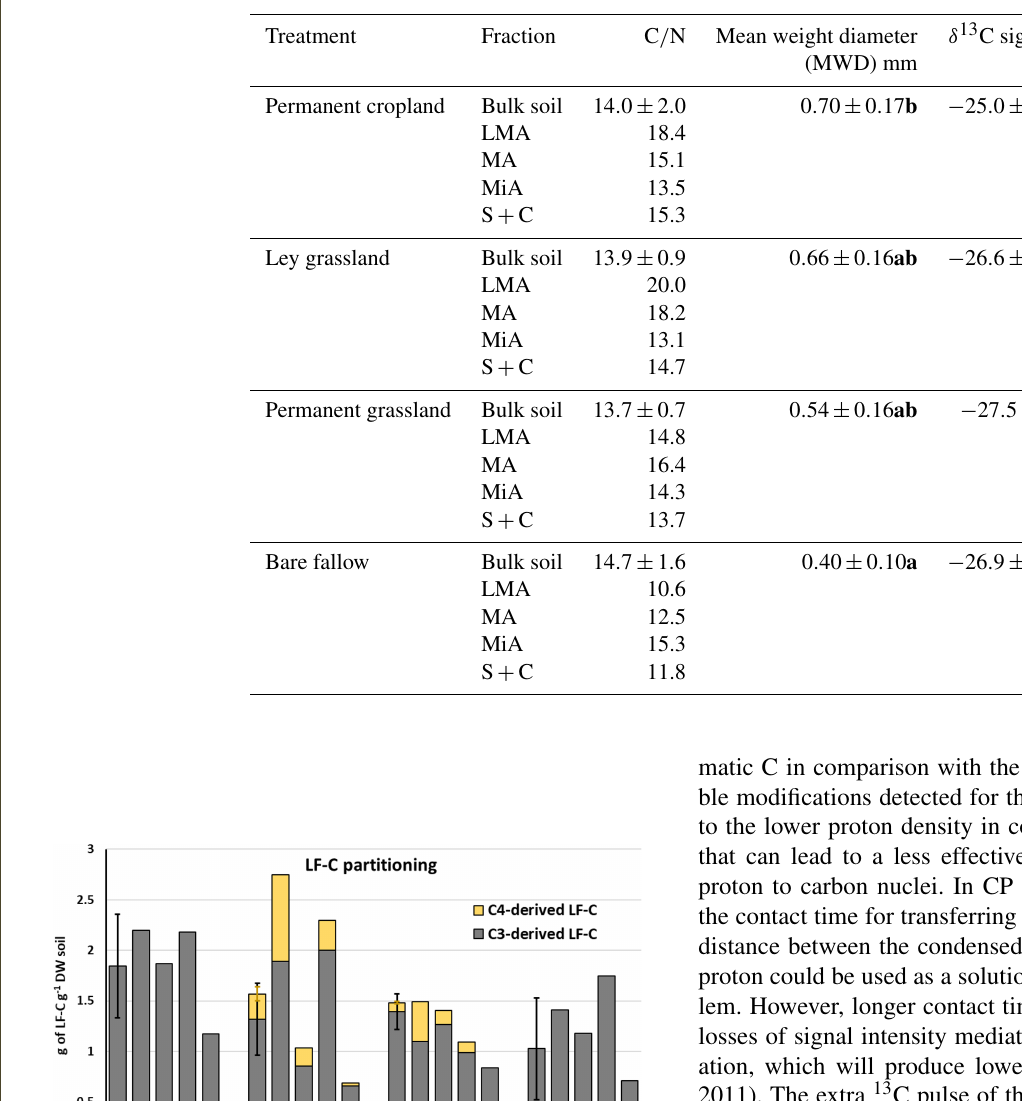
Table 2. C to N ratios, mean weight diameter (MWD), and δ 13 C signature measured for the bulk soil and aggregate fractions of four treatments. Significant differences between treatments ( P < 0 . 05) for bulk soil samples, according to the Kruskal–Wallis test, are indicated with different bold letters. Note: LMA – larger macroaggregate; MA – macroaggregate; MiA – microaggregate; and S + C – silt and clay.